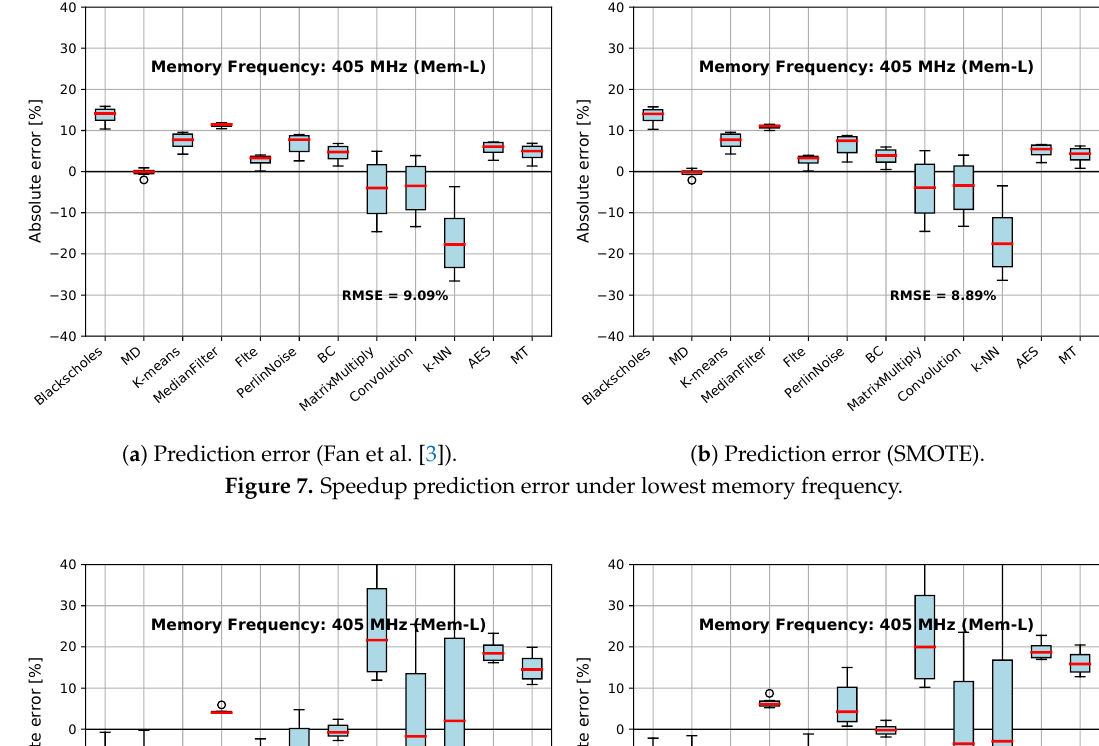
Figure 7. Speedup prediction error under lowest memory frequency.